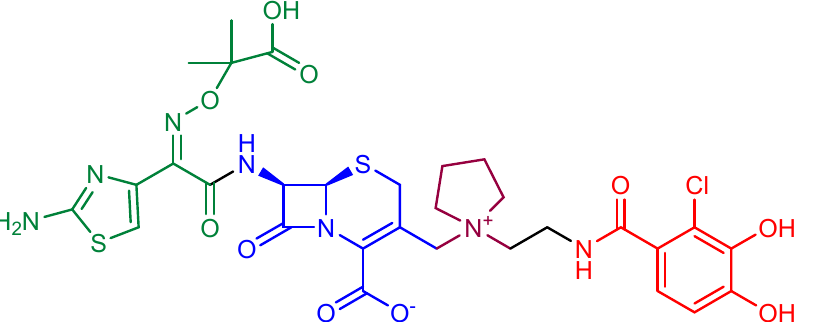
Figure 12. Chemical structure of cefiderocol. The cephalosporin core is in blue, the green part is the sidechain inspired by ceftazidime, the purple part is the sidechain inspired by cefepime, and the red moiety is the siderophore.